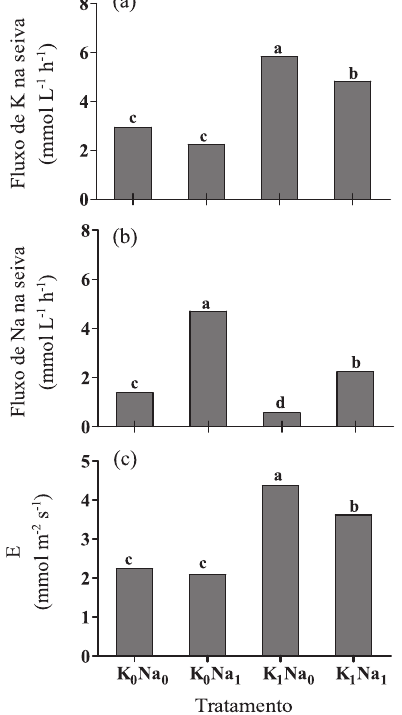
figura 1. fluxo de (a) K e (b) na na seiva de xilema e (c) transpiração em plantas de